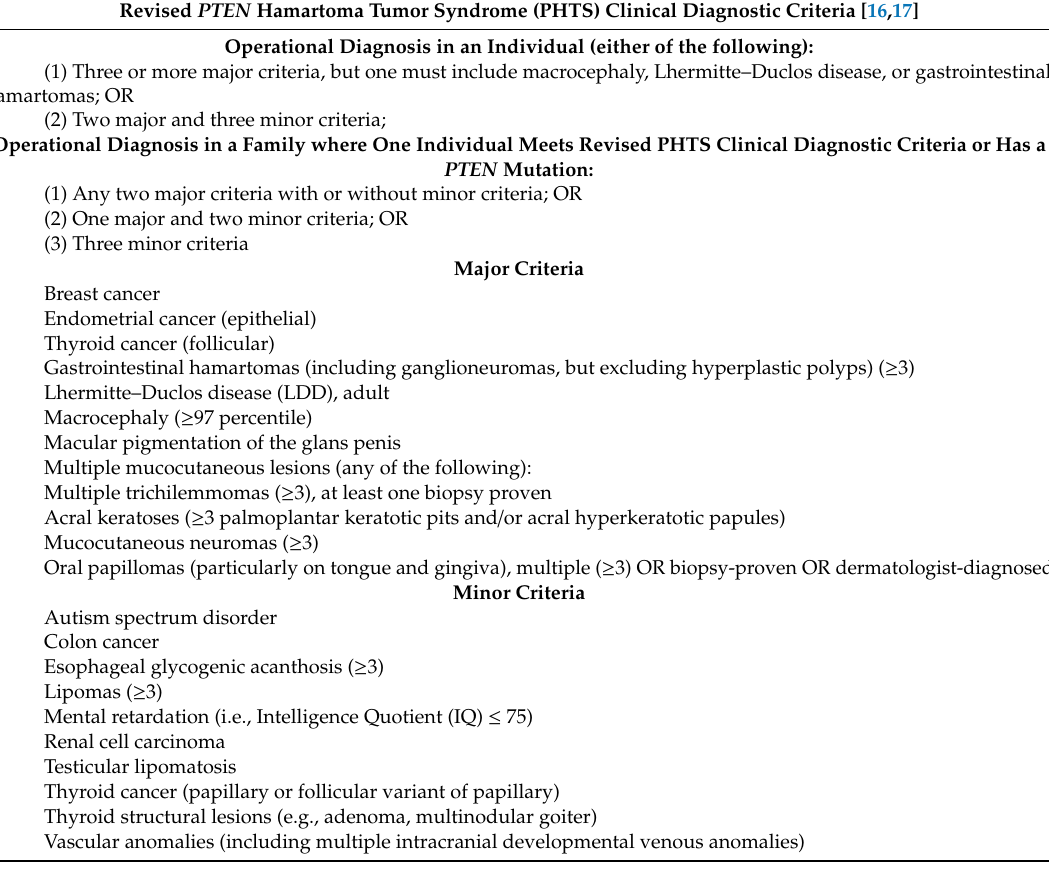
Table 1. Revised PTEN hamartoma tumor syndrome (PHTS) diagnostic